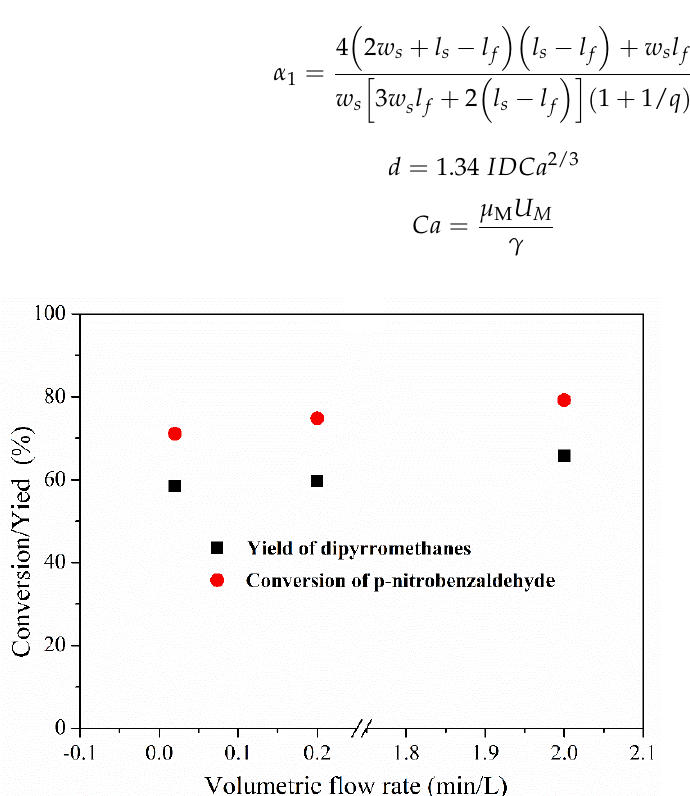
Figure 10. Conversion of p-nitrobenzaldehyde and the yield of 2,2 (cid:48) -(4-nitrophenyl) dipyrromethane in the liquid–liquid slug-flow microreactor.